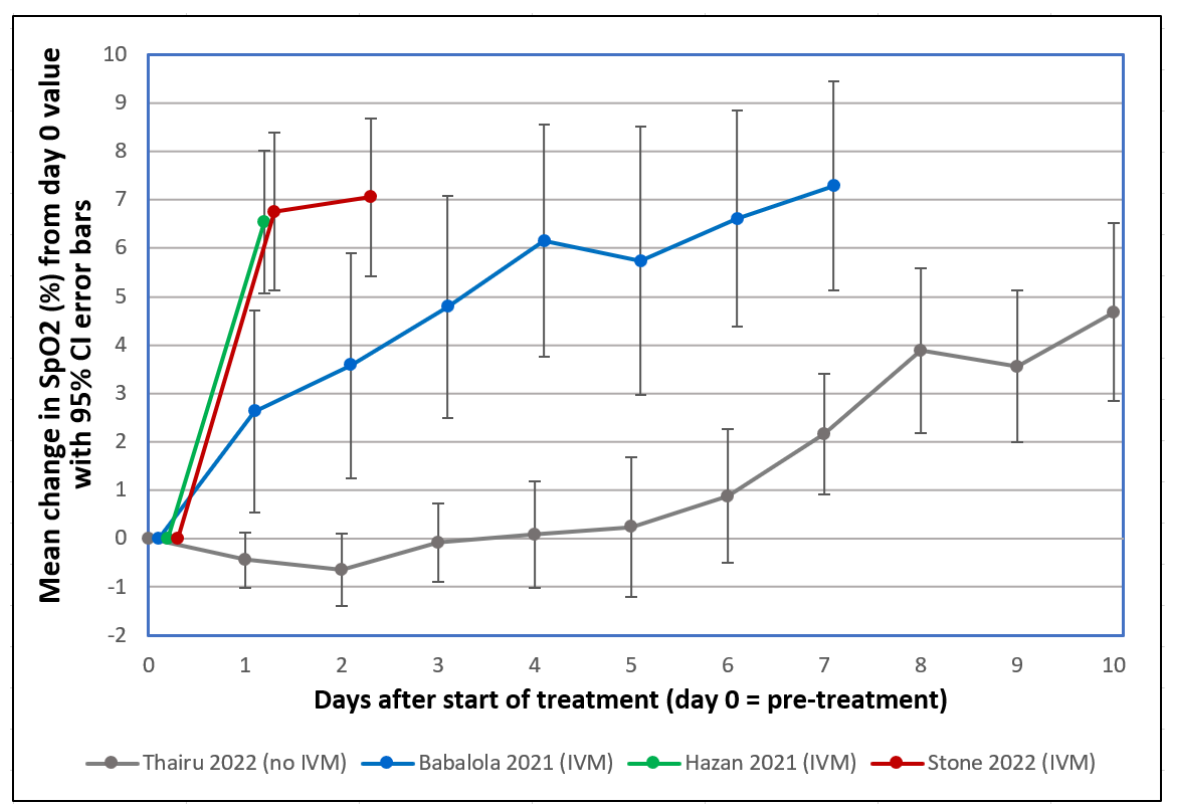
Figure 6. Mean changes in oxygen saturation (SpO2) for severe COVID-19 patients following treatments including or excluding IVM. Reproduced from Stone et al., 2022 [64] (CC-BY 4.0). Patients tracked over various time periods from each regimen were those with SpO2 values all recorded on room air, having pre-treatment (day 0) values ≤ 93%. The y-axis value at day n is the mean of changes in SpO2 values from day 0 to day n, with error bars designating 95% confidence intervals. ● Thairu et al., 2022 [83,84]: 26 patients, median age 45, treated with varying combinations of lopinavir/ritonavir (Alluvia), remdesivir, azithromycin, and enoxaparin as well as zinc sulfate and vitamin C. ● Babalola et al., 2021 [84,85]: 19 patients, median age 33, treated with IVM, zinc and vitamin C, with some also given azithromycin and hydroxychloroquine. ● Hazan et al., 2021 [86]: 19 patients, median age 63, treated with IVM, doxycycline and zinc. ● Stone et al., 2022 [64]: 34 patients, median age 56.5, treated with IVM, doxycycline and zinc.